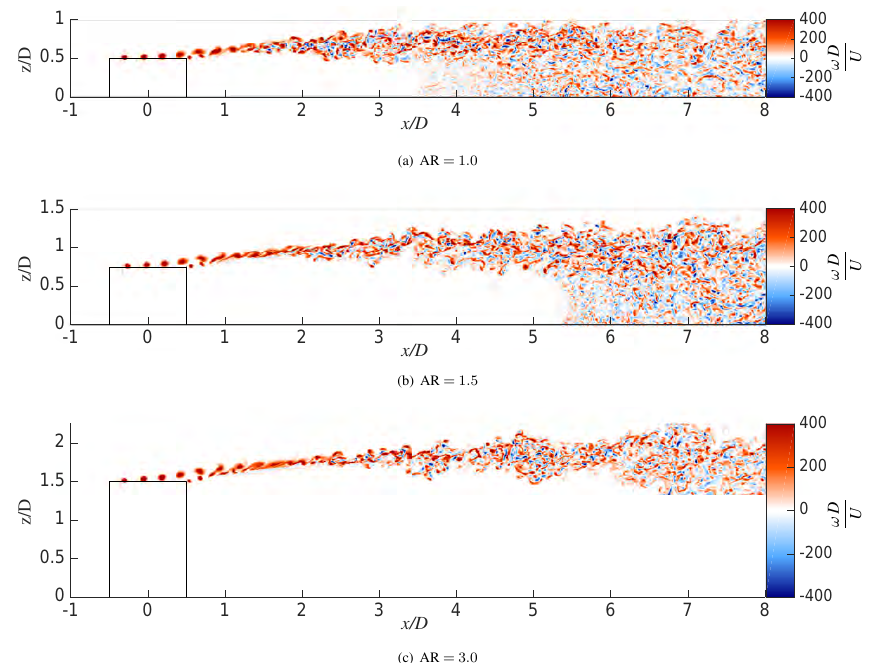
Figure 6. Effect of aspect ratio at TSR = 3 . 21: contours of the instantaneous cross-stream vorticity component ω y D/U ∞